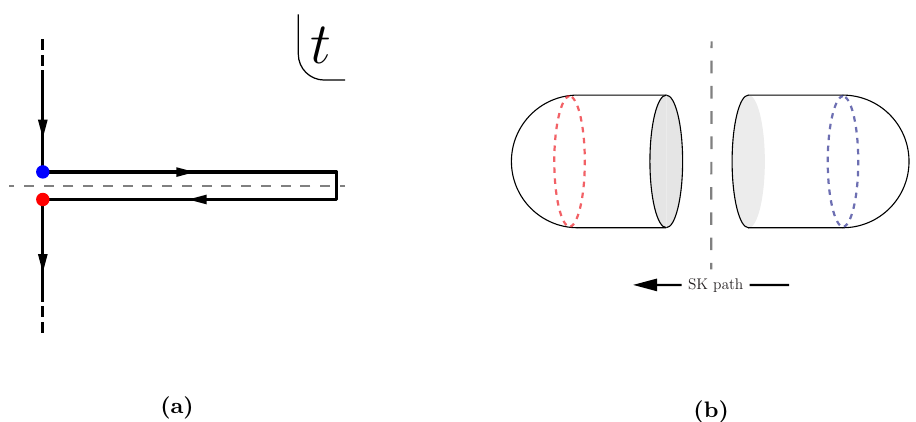
Figure 2. (a) In-In SK path. The state used for computing the expectation value is prepared by Euclidean path integrals represented by the vertical segments. The upper horizontal real time segment corresponds to the system evolving in time, it is there that operators are inserted. The lower horizontal segment is usually associated to the environment DOFs in interaction with the system. The dashed grey line emphasizes a “mirror” symmetry in the complex plane that helps build the geomtric dual. (b) Bulk dual for the In-In SK path. We retain the grey dashed line to ease its